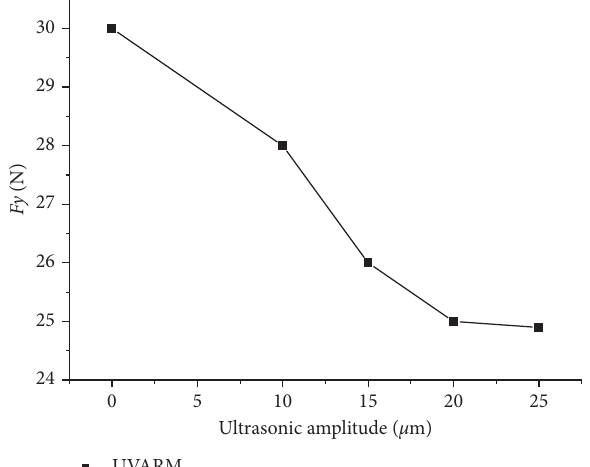
Figure 18: Fy changes with ultrasonic amplitude.